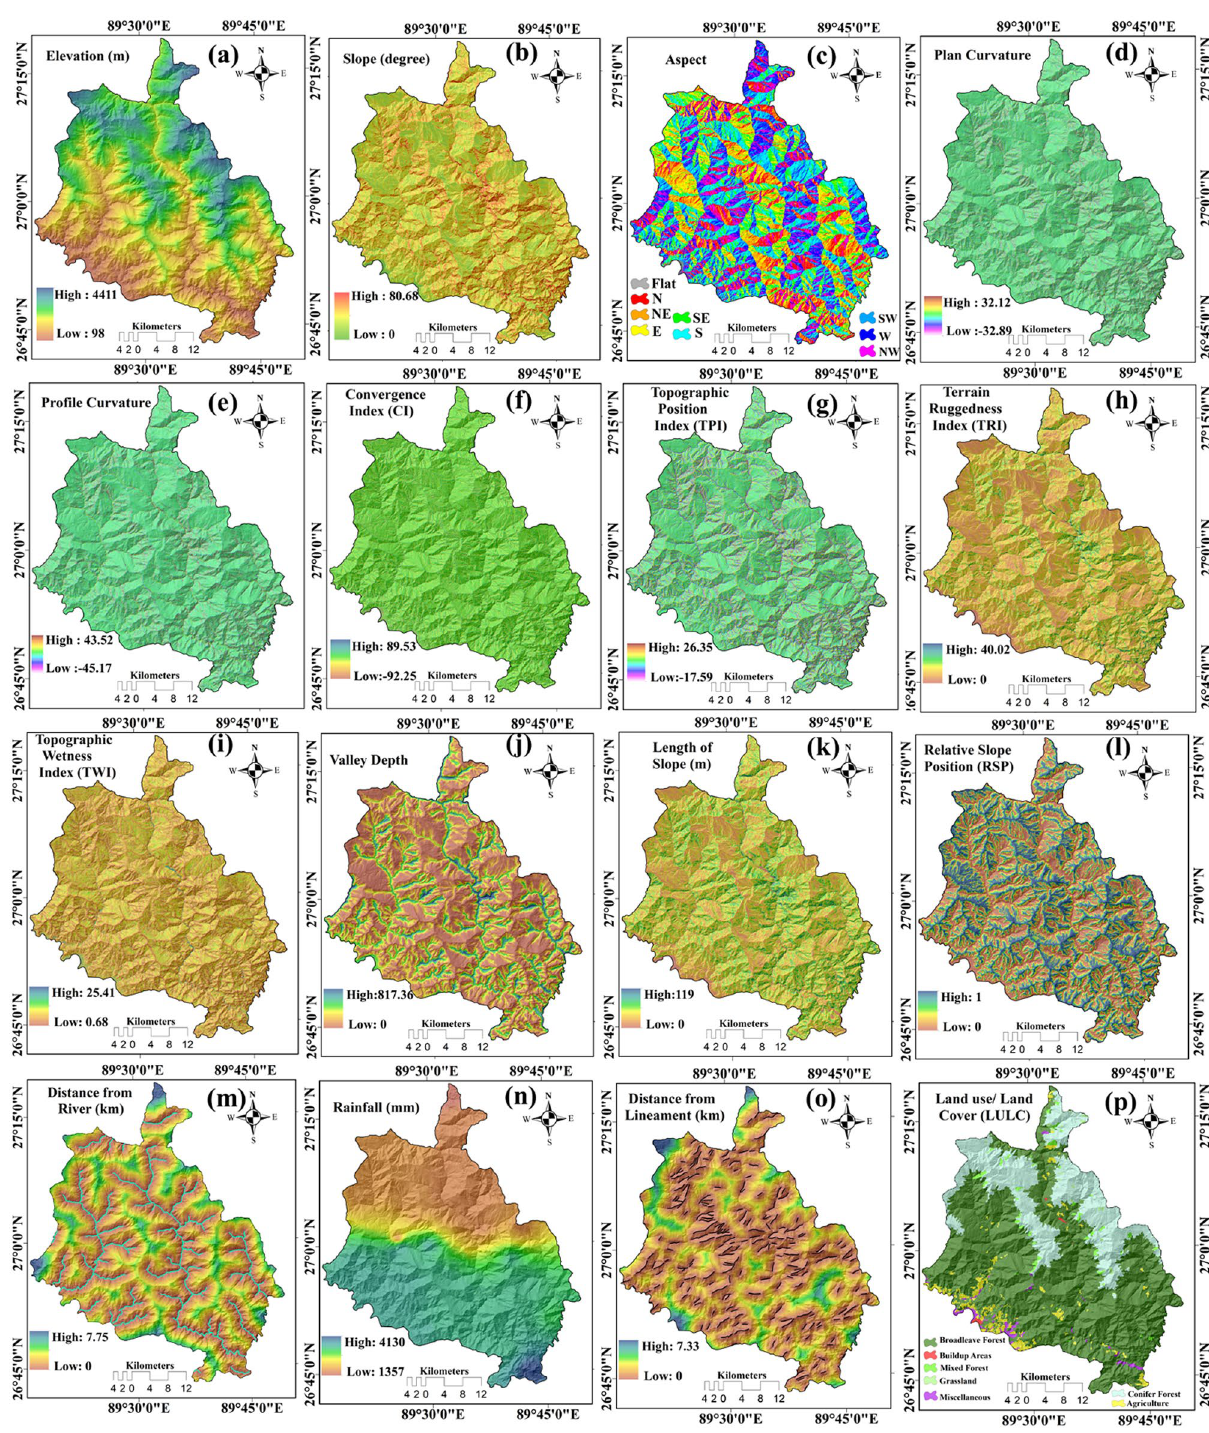
Figure 4. Factors used for producing the landslide susceptibility maps—( a ) Elevation, ( b ) Slope, ( c ) Aspect, ( d ) Plan curvature, ( e ) Profile curvature, ( f ) Convergence index, ( g ) Topographical position index, ( h ) Terrain ruggedness index, ( i ) Topographical wetness index, ( j ) Valley depth, ( k ) Length of slope, ( l ) Relative slope position, ( m ) Distance from river, ( n ) Rainfall, ( o ) Distance from lineament, ( p ) Land use/land cover, ( q ) Normalized differential vegetation index (NDVI), ( s ) Geology map, ( s ) Sand, ( t ) Clay, ( u ) Silt, ( v ) Soil